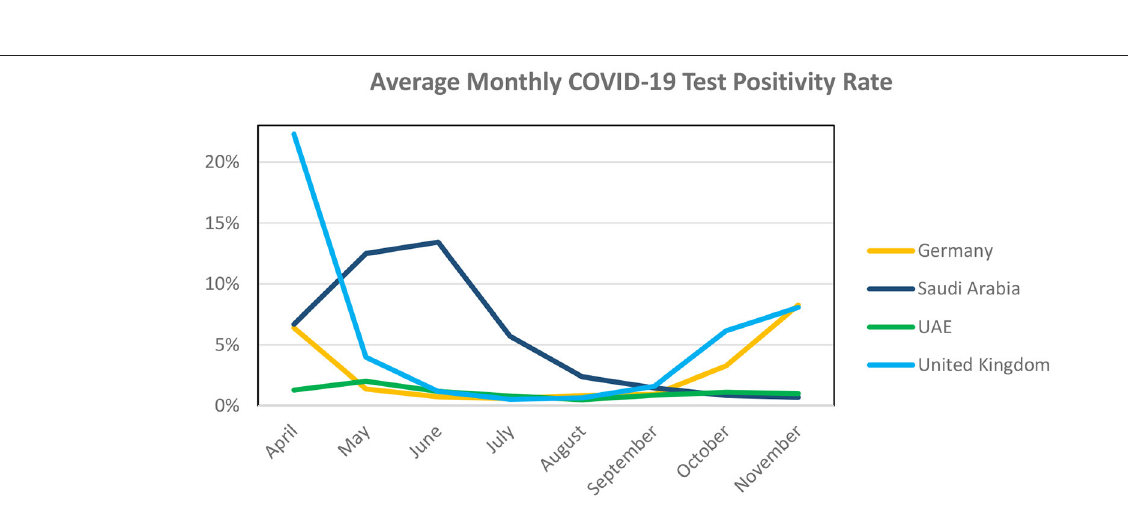
TABLE 3 | Week 46: total COVID-19 testes per thousand and deaths per million. Country Total test per Deaths per million thousand (week 46) (week 46) Germany 316 150 Saudi Arabia 257 162 UAE 1515 United Kingdom 496